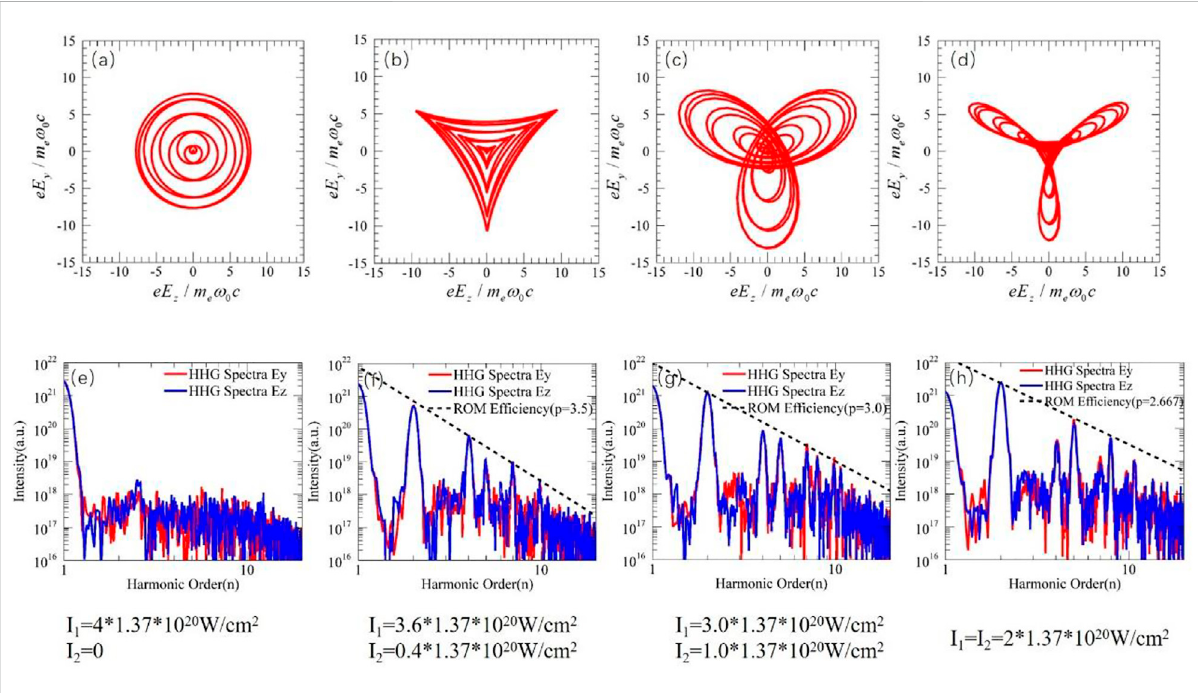
FIGURE 7 Polarization plane projections of the laser electric fi elds generated with intensity ratios (A) I 2 ω / I ω (cid:2) 0, (B) I 2 ω / I ω (cid:2) 0 . 1, (C) I 2 ω / I ω (cid:2) 0 . 33, and (D) I 2 ω / I ω (cid:2) 1. The total intensity is kept constant ( I 2 ω + I ω (cid:2) 5 . 48 × 10 20 W / cm 2 ). (E – H) The produced harmonic spectra corresponding to the driving fi elds shown in panels (A – D)